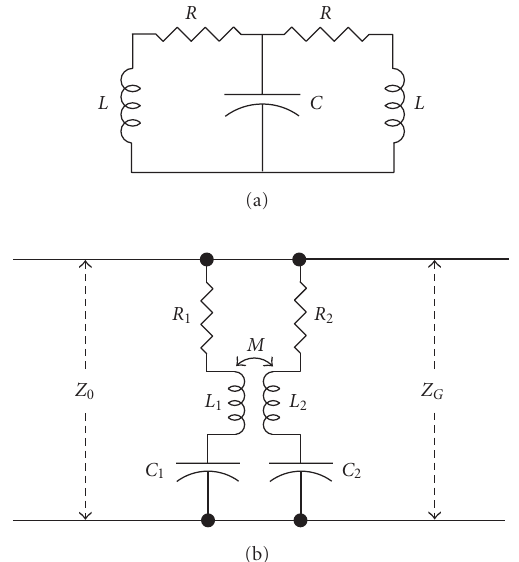
Figure 6: Circuit models for metafilm samples. (a) A series RLC circuit commonly used to describe the Lorentzian response of meta- materials. (b) The transmission-line RLC model which incorporates the e ff ects of the substrate and uses a transformer to model the cou- pling between resonant